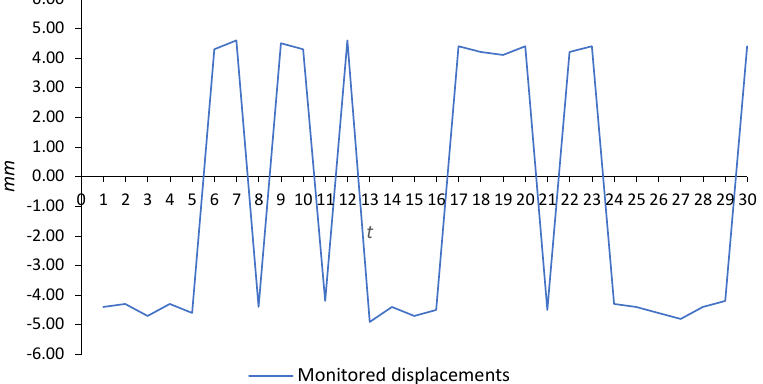
Figure 5. Displacements of the marker M4 along the x -axis.